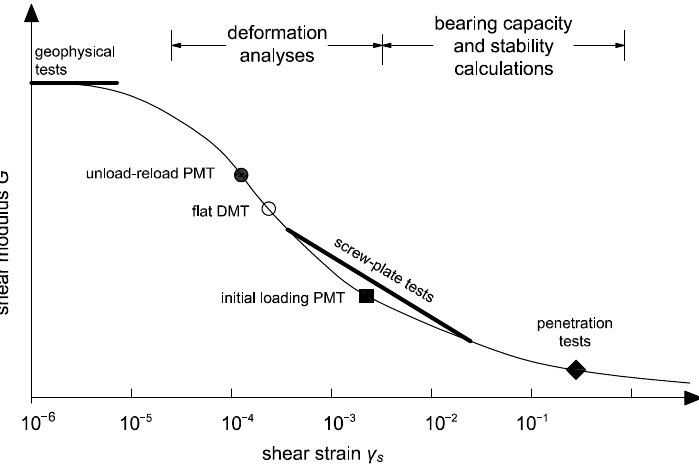
Figure 1. Variation of shear modulus with strain level for in situ tests [15].